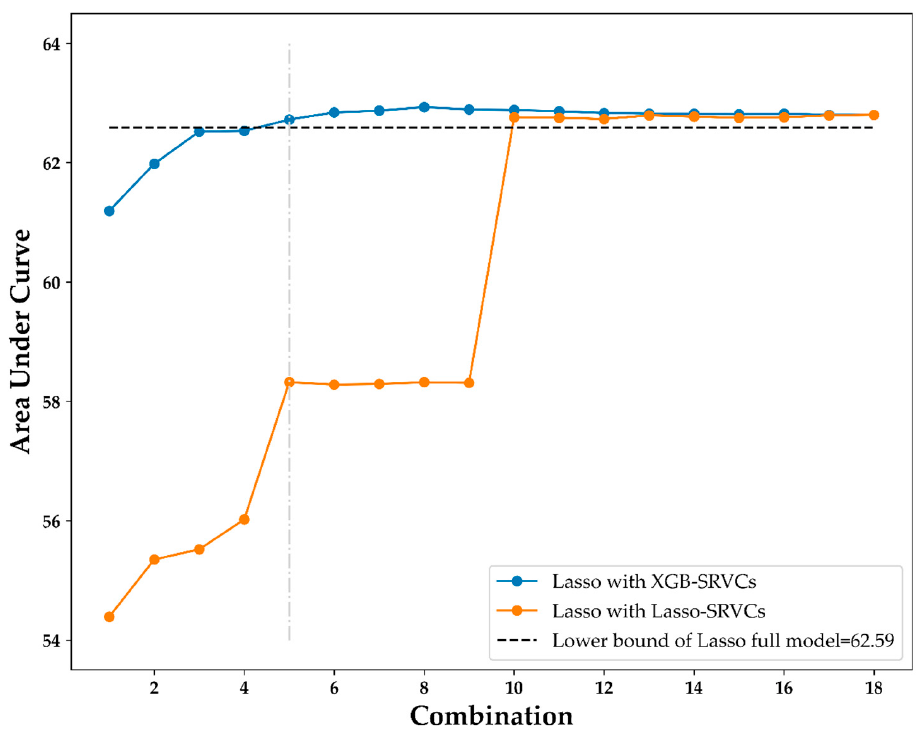
Figure 4. Lasso results comparison using XGB-SRVCs and Lasso-SRVCs.